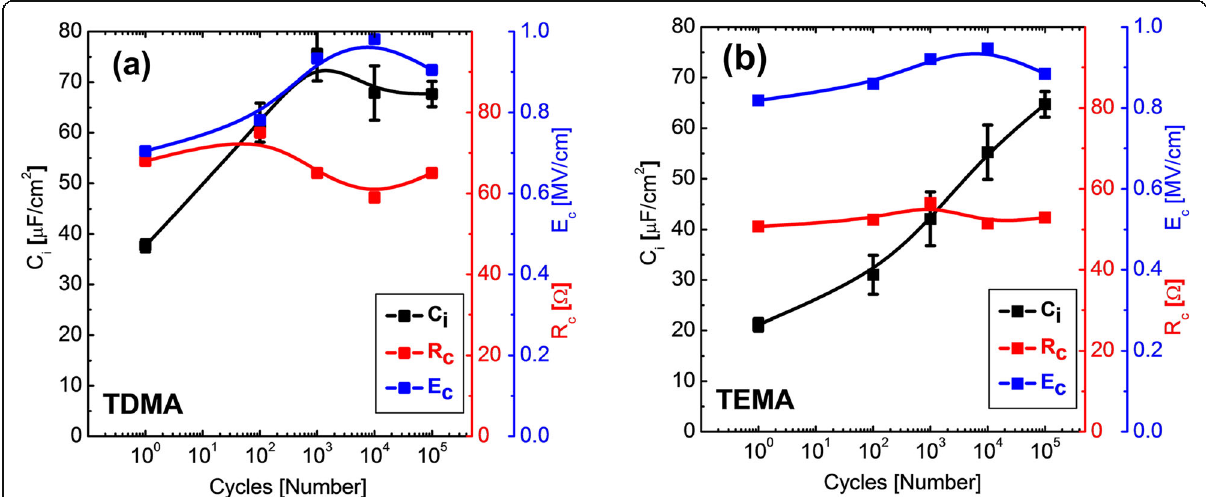
Fig. 3 The changes of ( a ) TDMA HZO and ( b ) TEMA HZO (reproduced from Ref. [5]) in interfacial capacitance (C i ), contact resistance (R c ), and coercive field (E c ) values with increasing number of fatigue